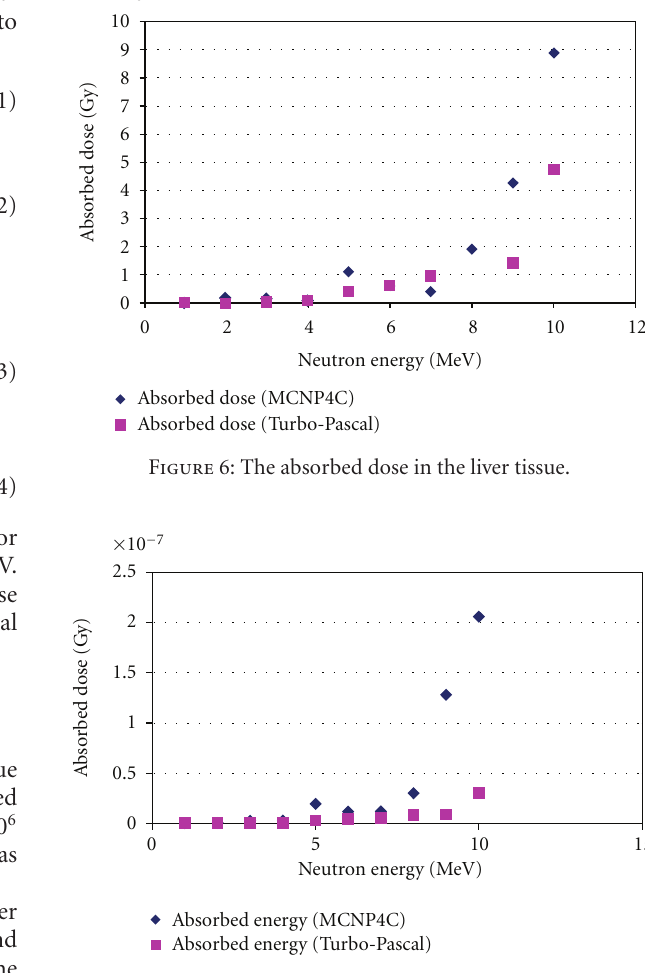
Figure 7: The absorbed dose in the polyethylene